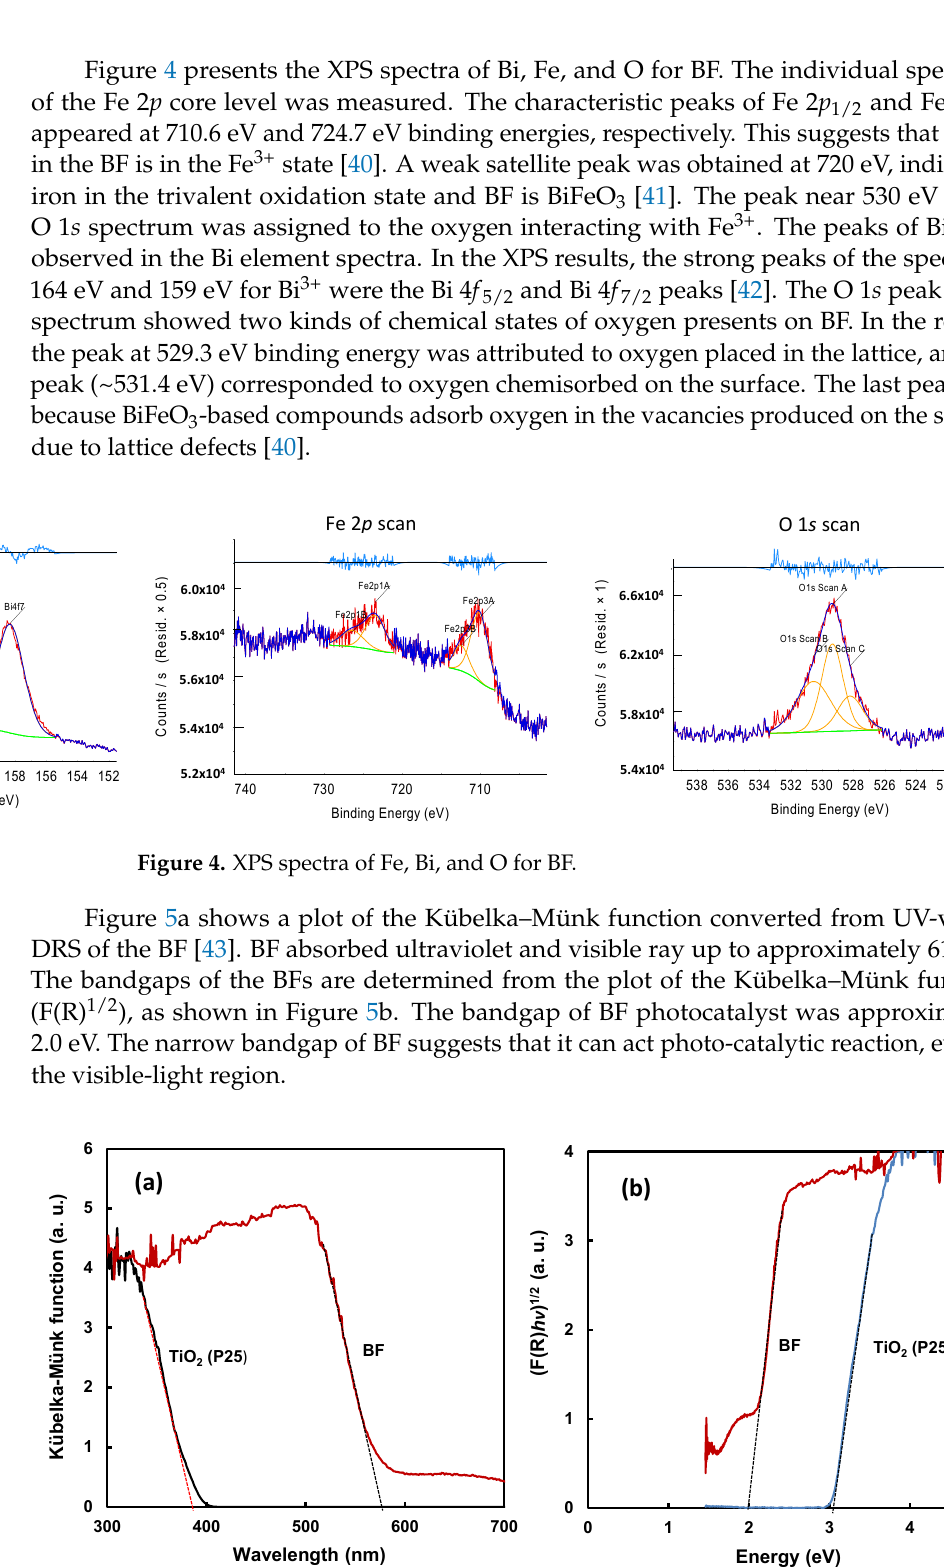
Figure 3. The entire XPS spectrum of BF.